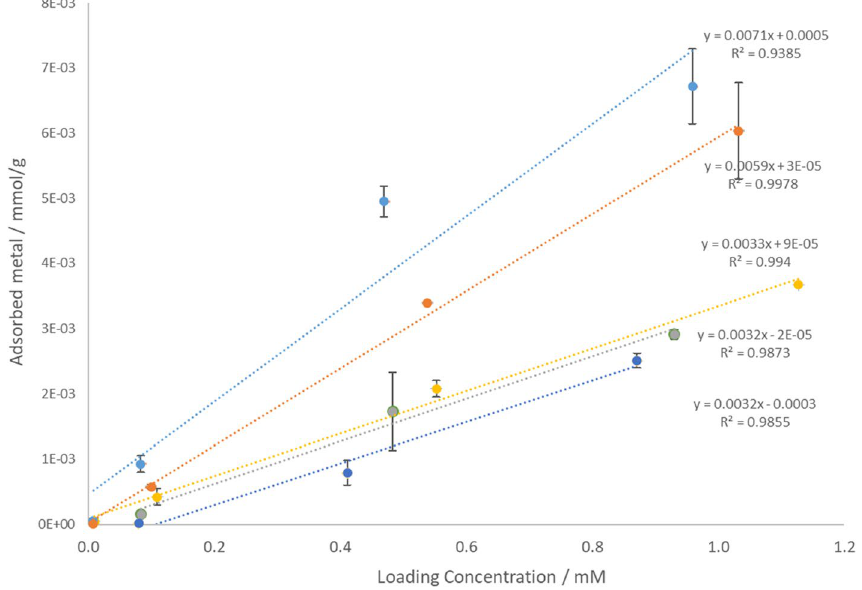
Figure 4. Graph of the adsorbed metal ion (mol·g −1 ) Cd 2+ , Co 2+ , Cu 2+ , Ni 2+ , and Zn 2+ at the investigated metal ion loading concentrations, excluding the 10 mM solution to avoid artifact due to the saturation of the binding sites. From top to bottom, the elements reported are (light blue) Cu 2+ , (orange) Ni 2+ , (yellow) Co 2+ , (grey) Cd 2+ and (blue) Zn 2+ . The standard deviation is